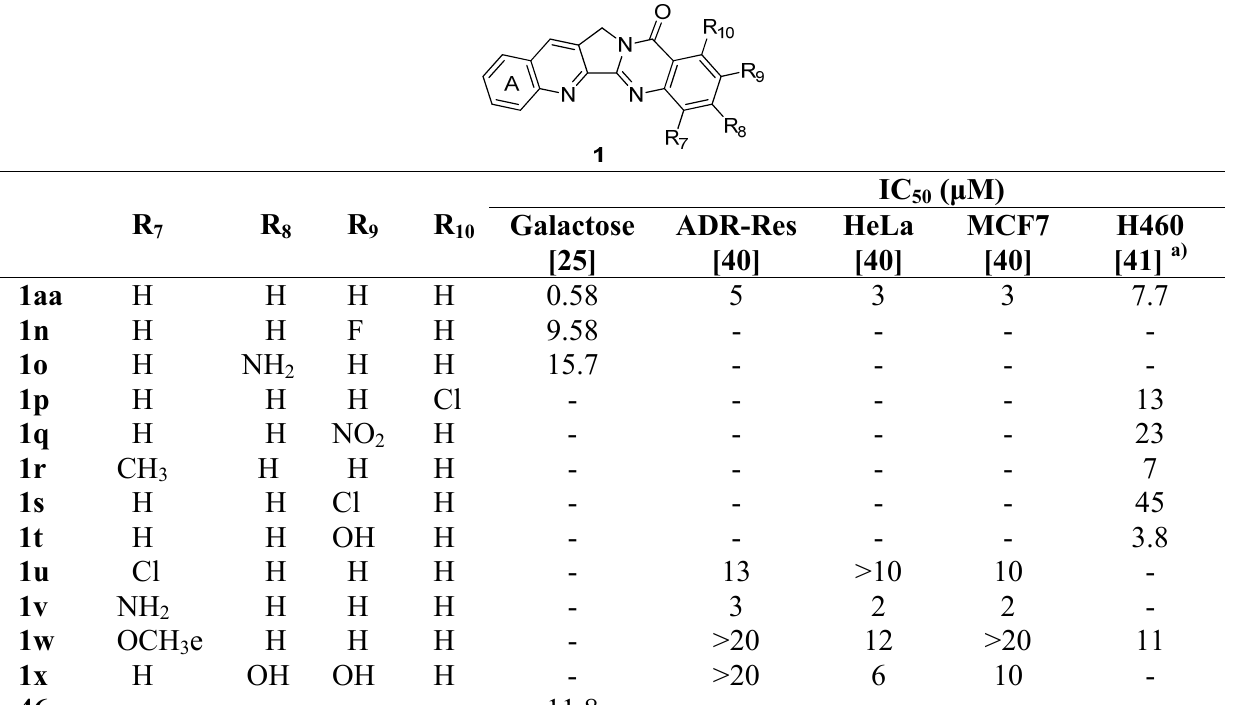
Table 3. Cytotoxicities of derivatives of luotonin A on ring E and